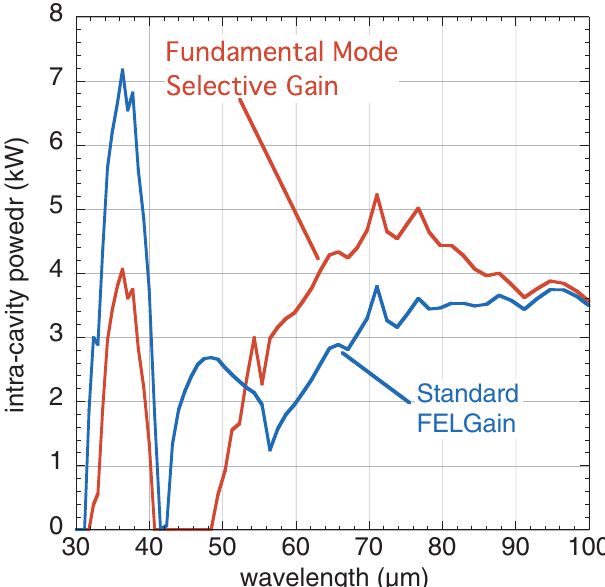
FIG. 8. (Color) Simulation, intracavity power P in , as a function of wavelength, for toroidal